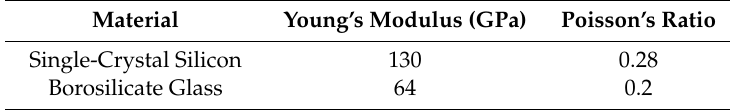
Table 1. Material properties used in the simulation.